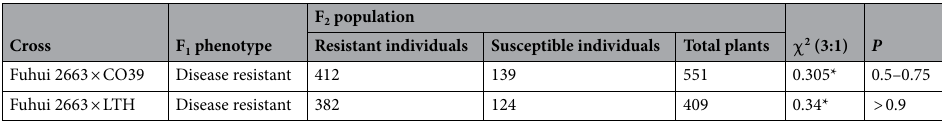
Table 2). Six markers (Indel-11, Indel-22, Indel-26, Indel-30, Indel-33, and Indel-12) were used for recombinant screening, and 12, 5, 2, 0, 1, and four recombinant plants were detected, respectively. Therefore, the resistance gene was precisely located in the estimated 80 kb region between Indel-26 and Indel-33 (Fig. 2d). Candidate genes in the 80 kb region. According to the existing sequence annotation databases (http:// rice. plant biolo gy. msu. edu/; http:// www. tigr. org/), there were eight candidate genes in the 80 kb region identified